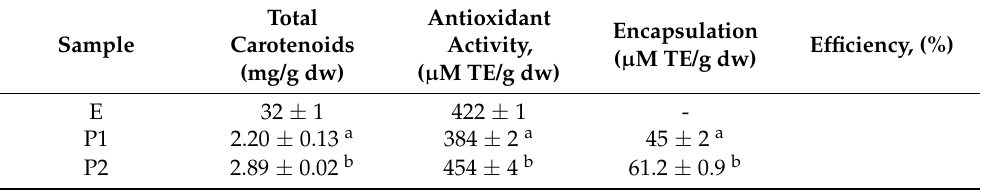
Table 1. Phytochemical characterization of sea buckthorn’s extract and microencapsulated powders. Antioxidant Total Encapsulation Efficiency, (%) Activity, Sample Carotenoids ( µ M TE/g dw) ( µ M TE/g dw) (mg/g dw) E 32 ± 1 422 ± 1 - P1 2.20 ± 0.13 a 384 ± 2 a P2 454 ± 4 b 61.2 ± 0.9